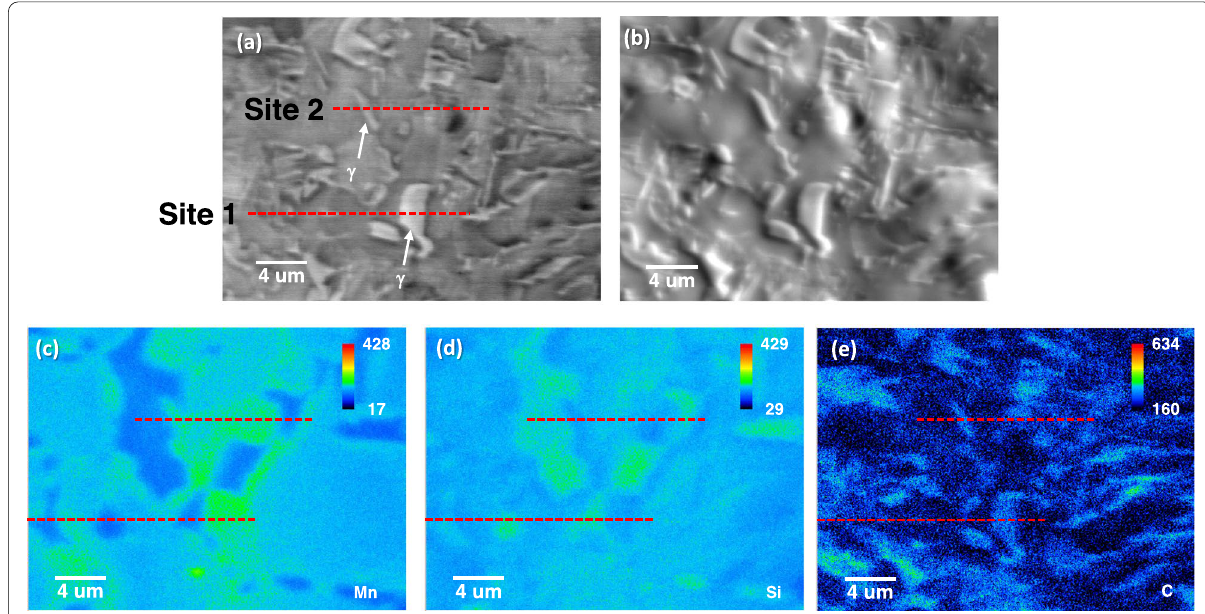
Fig. 8 EPMA analysis of the retained γ; a backscattered electron and b SE images, and EPMA c Mn Kα, d Si Kα, and e C Kα maps. 20 kV, 3 and 15 ms were used for the data